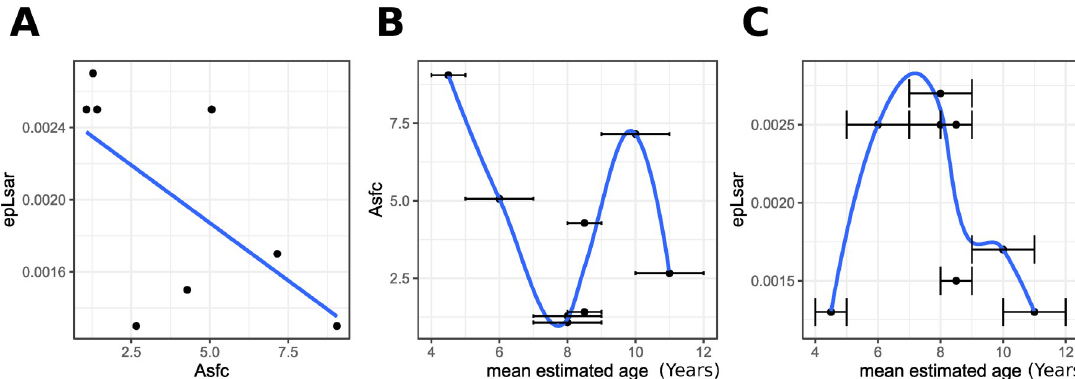
Fig 5. Dental microwear analysis also indicates both age dependent and independent intra-population dental wear variation. (A) Scatterplot of surface anisotropy (epLsar) by surface complexity (Asfc). (B) Scatterplot of surface complexity (Asfc) by mean estimated age with age estimation uncertainty error bars, a loess curve is used to better represent the non-linear relationship between the variables. (C) Scatterplot of surface anisotropy (epLsar) by mean estimated age with age estimation uncertainty error bars, a loess curve is used to better represent the non-linear relationship between the